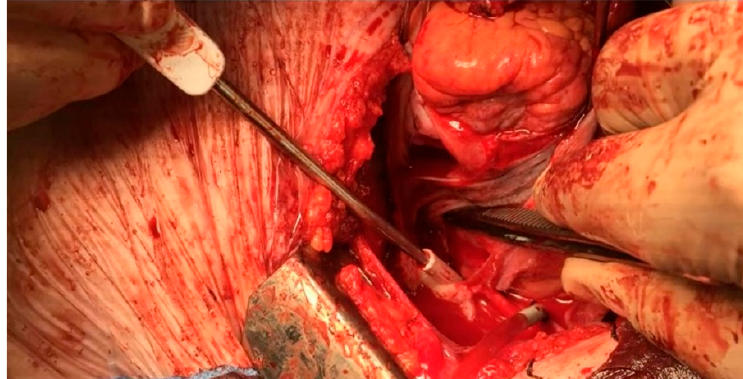
Figure 3. Intraoperative view of the unroofed coronary sinus.